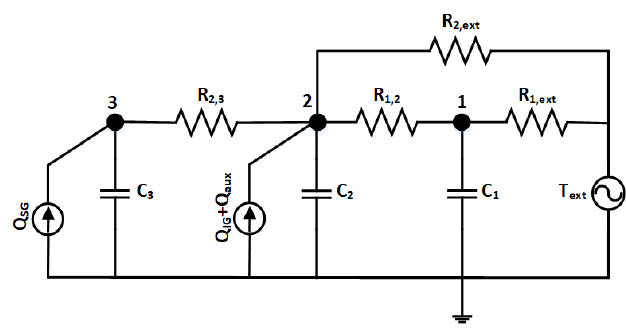
Figure 1. Thermal network model of the zones with convective system. Table 1. Description of RC thermal network model parameters